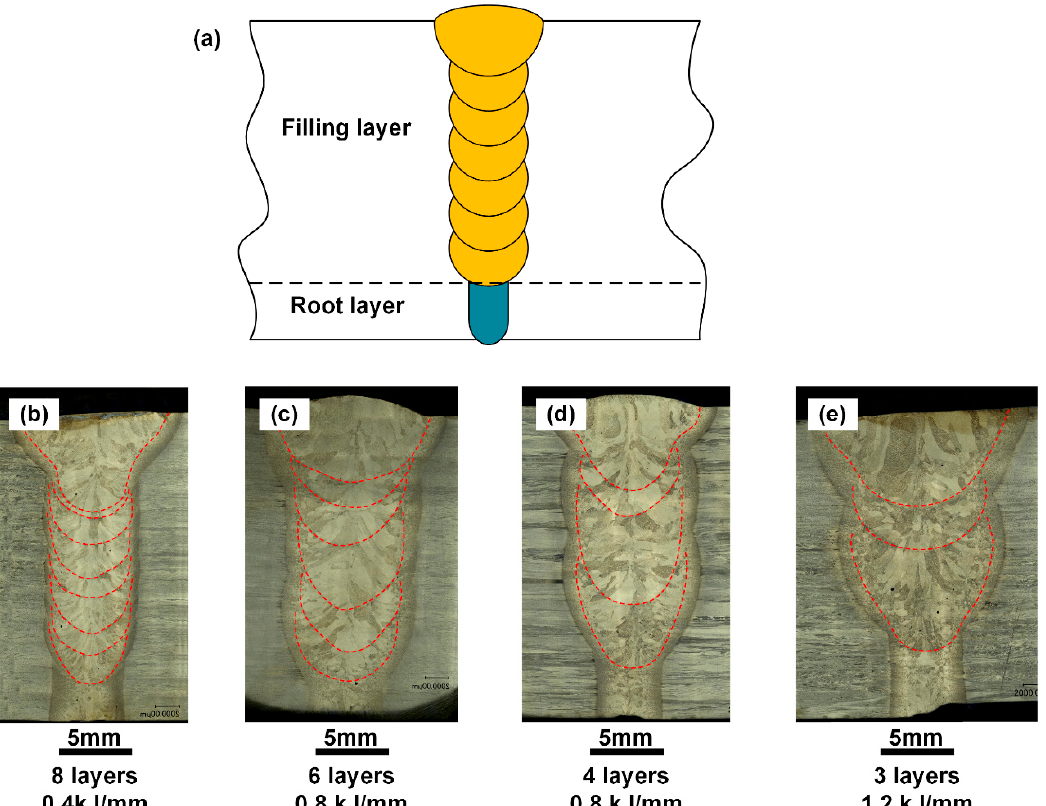
Figure 4. Weld surface and section forming. ( a ) Filling weld schematic; ( b ) 8 layers with 0.4 kJ/mm; ( c ) 6 layers with 0.8 kJ/mm; ( d ) 4 layers with 0.8 kJ/mm; ( e ) 3 layers with 1.2 kJ/mm.